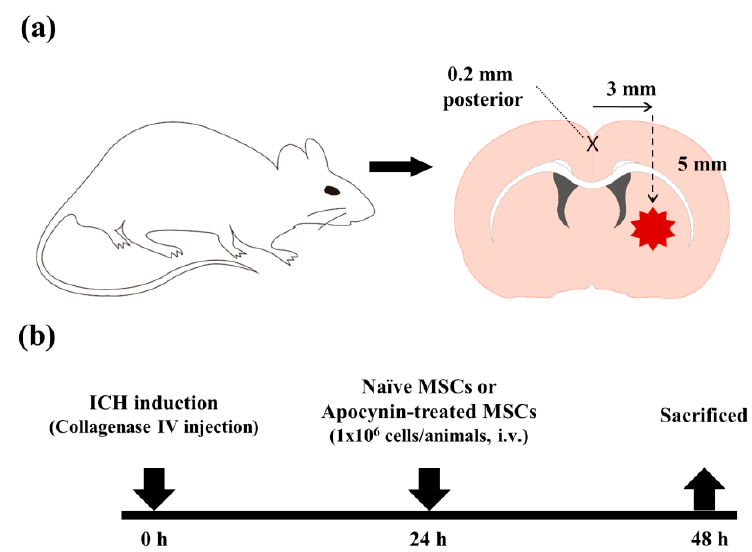
Figure 4. Conceptual illustrations of the experimental protocol. ( a ) Schematic diagrams of a rat intracranial hemorrhage (ICH) model. ICH was induced by the infusion of bacterial collagenase type IV (0.1 U, 1 μ L) into the striatum. ( b ) Brief timeline of the experimental procedures.